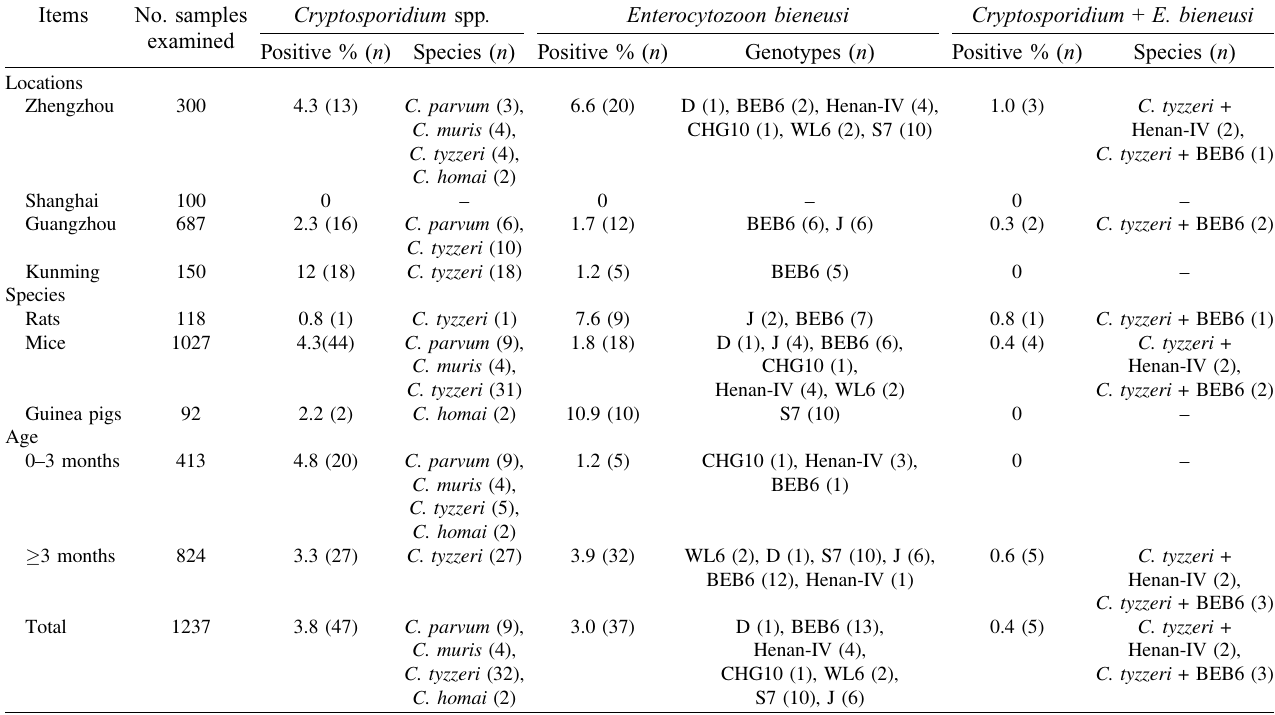
Table 1. Occurrence and genotypic distributions of Cryptosporidium spp. and Enterocytozoon bieneusi in certain laboratory rodents in China. Items No. samples